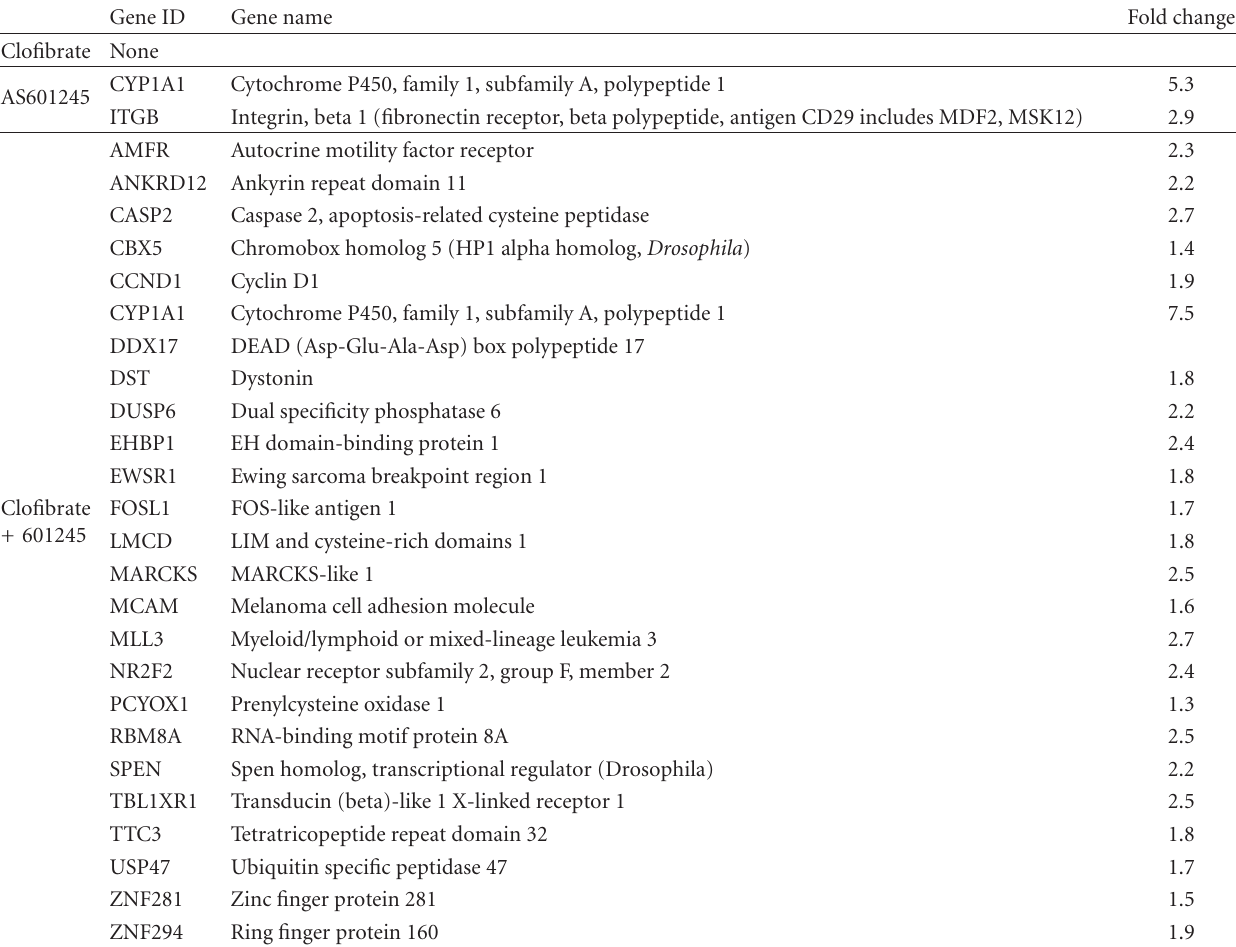
b The genes harbouring PPRE sequences among the upregulated genes by treatment with 5 μ M clofibrate, 0.1 μ M AS601245, and combined treatment versus DMSO-treated Caco-2 cells at